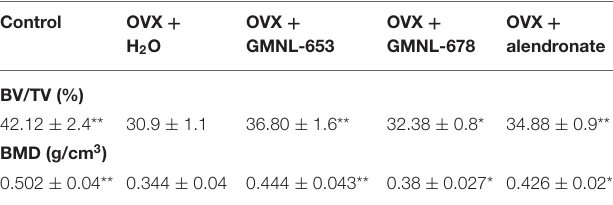
TABLE 1 | Heat-killed L. paracasei (GMNL-653) protect mice from ovariectomy-induced bone